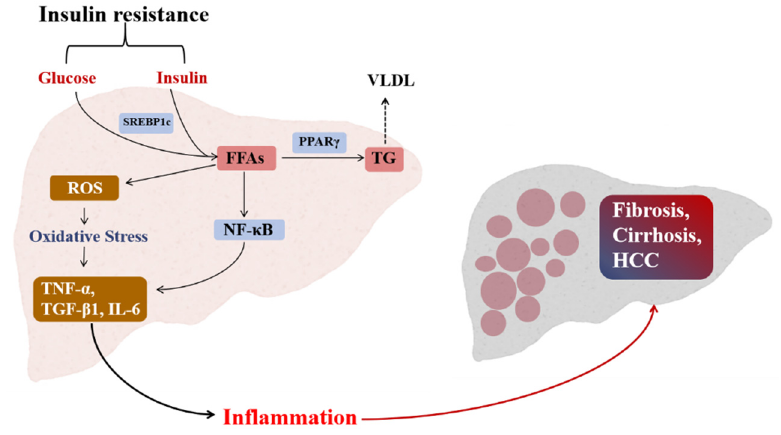
Figure 1. An overview of the pathophysiological mechanisms that oxidative stress and inflammation in the development of non-alcoholic fatty liver disease. Briefly, free fatty acid (FFA) flux could activate the transcriptional factors such as peroxisome proliferator-activated receptor gamma (PPAR γ ). In an aggravated state, this process promotes the increased production of reactive oxygen species (ROS) and aberrant levels of pro-inflammation markers such as tumor necrosis factor-alpha (TNF- α ), the nuclear factor kappa B (NF- κ B) and transforming growth factor beta (TGF β -1). SREBP1c = sterol regulatory element-binding protein; TG = triglycerides; ROS = reactive oxygen species; IL-6 = interleukin 6; VLDL = very low-density lipoproteins.